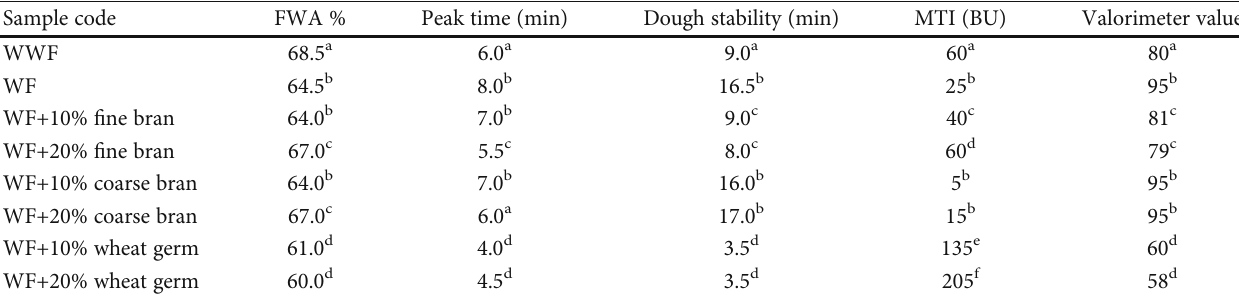
FWA: Farinograph water absorption; BU: Brabender units; MTI: mixing tolerance index: WWF: whole wheat fl our; WF: white fl our. Mean values ( N = 3 ) with same superscripts for any parameter do not di ff er signi fi cantly in a column ( P = 0 : 05